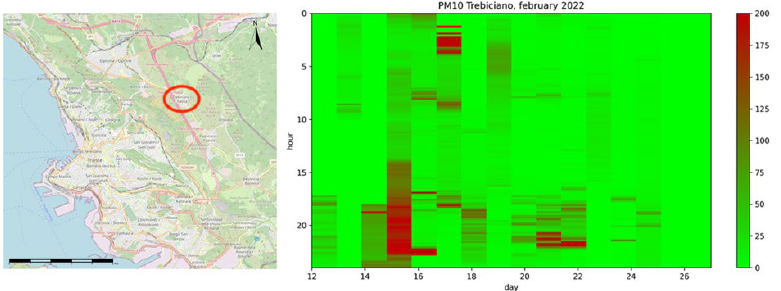
Figure 6. Heatmap of PM values in the village of Trebiciano in the Karst tableau (highlighted in red in the map on the left). The heatmap shows the distribution of PM values throughout the day (24 h) in two weeks. It is possible to identify a band characterized by high values between 5 p.m. and 11 p.m.